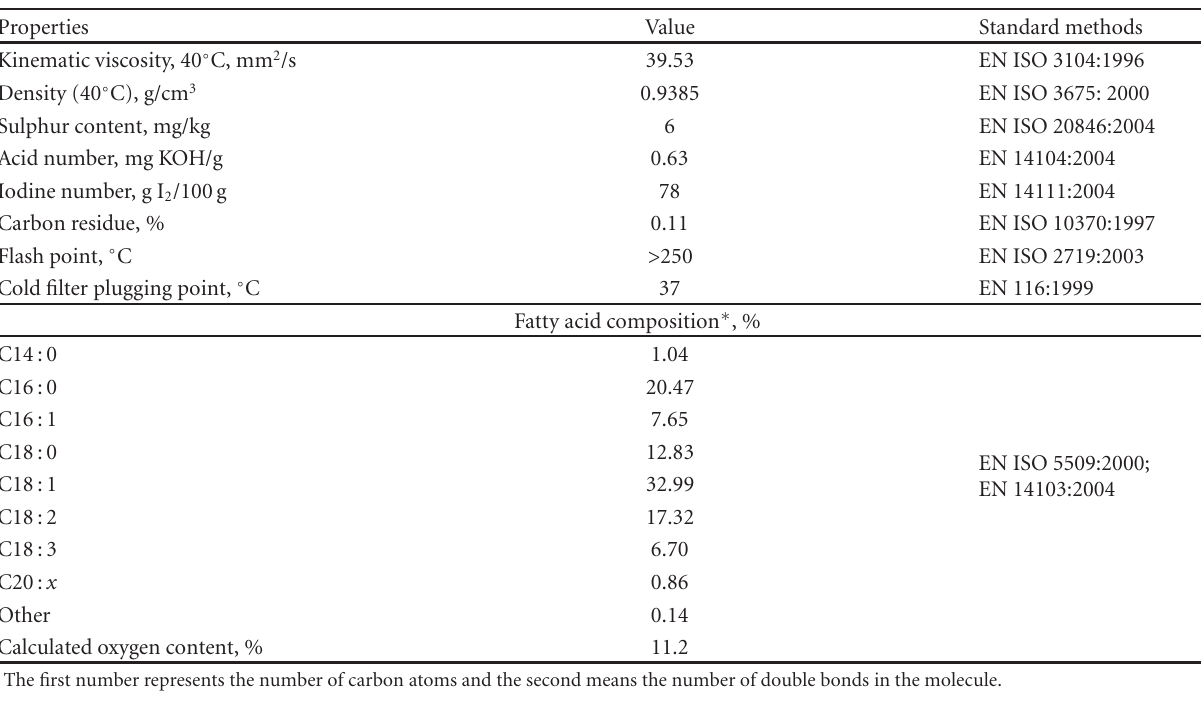
Table 1: The main properties and fatty acid composition of the applied waste lard.